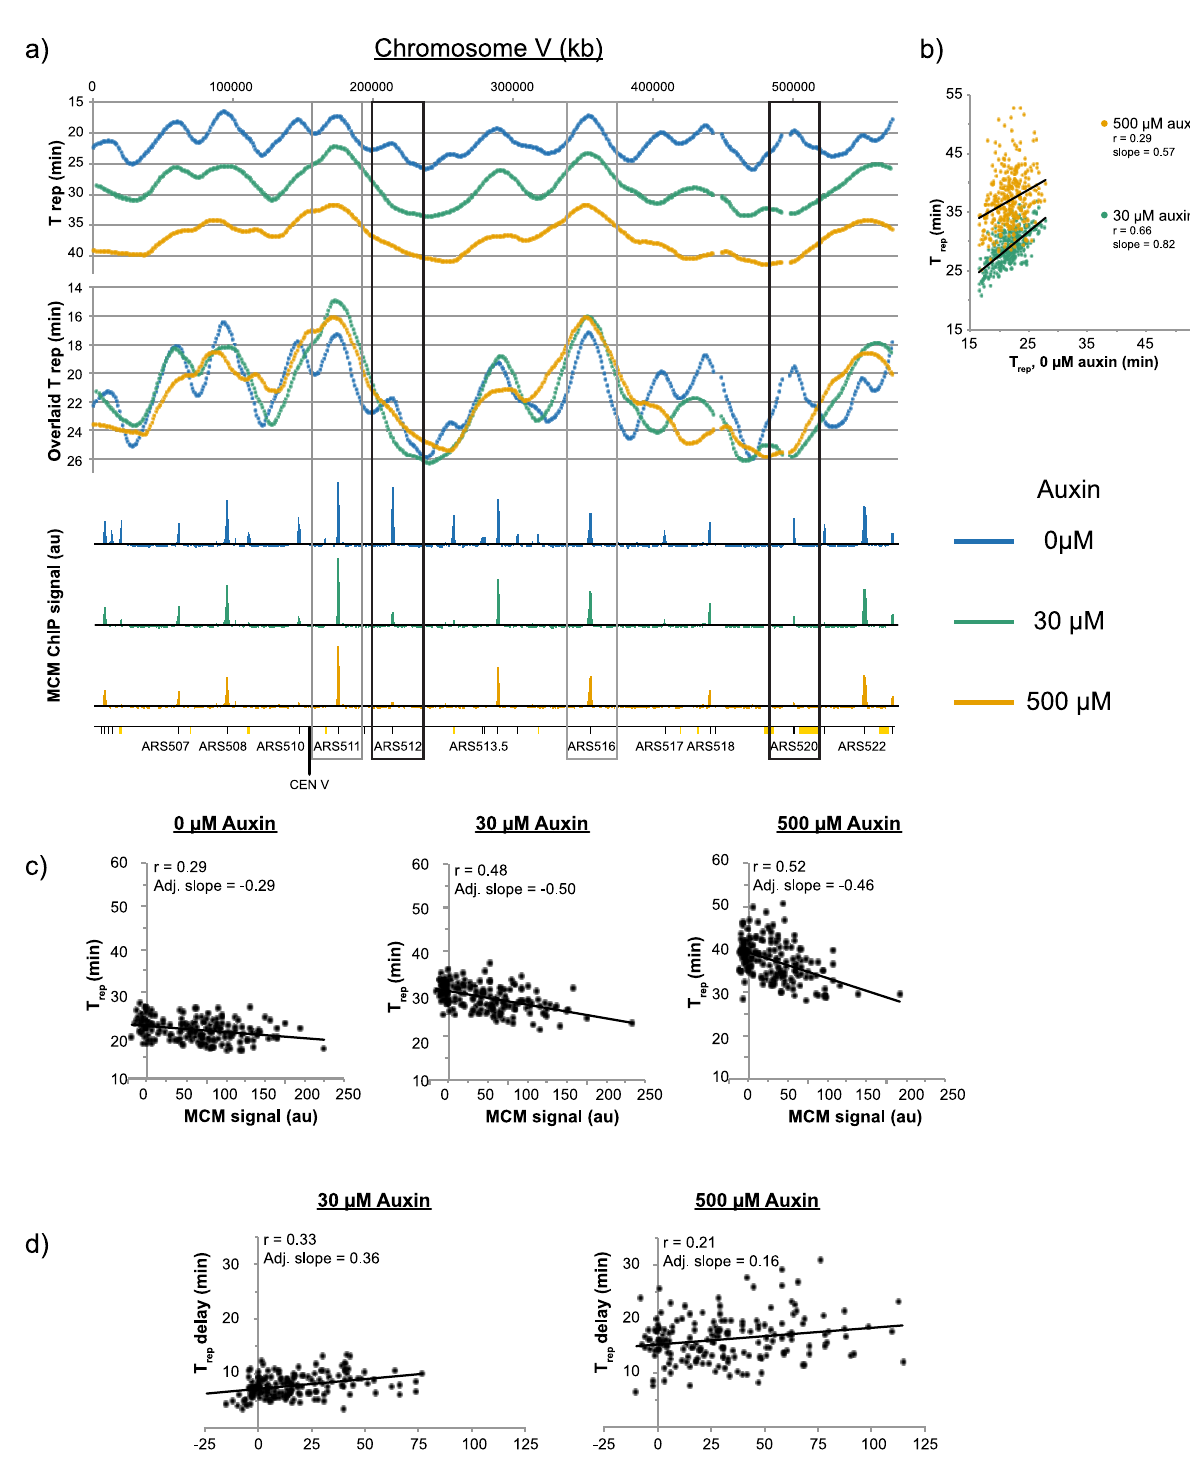
Fig 4. Delays in replication timing correlate with reductions in MCM levels. a) Chromosome V T rep values for the 0 μ M, 30 μ M, and 500 μ M auxin-treated yFS1059 was calculated in 1kb windows, LOESS-smoothed, and plotted based on their genomic location. “Overlaid T rep ” values have been overlaid in order to compensate for delays in replication initiation and facilitate comparison between samples. Black boxes indicate two origins that display strong correlation between the loss of MCM signal and delay in replication timing. Gray boxes indicate two origins that display strong correlation between the maintenance of MCM signal and maintenance in replication timing. ARS-annotated origins are indicated in black dashes on